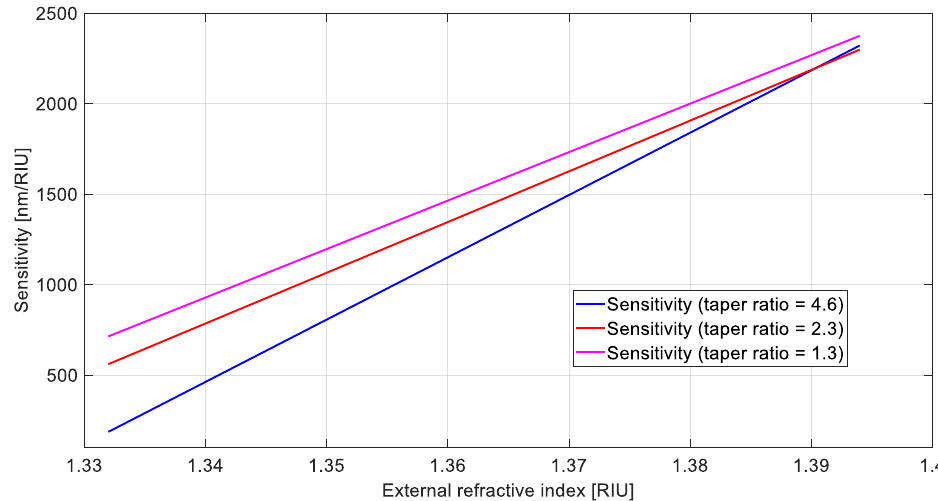
Figure 4. Sensitivity as a function of the refractive index for the configurations based on a tapered LDF.